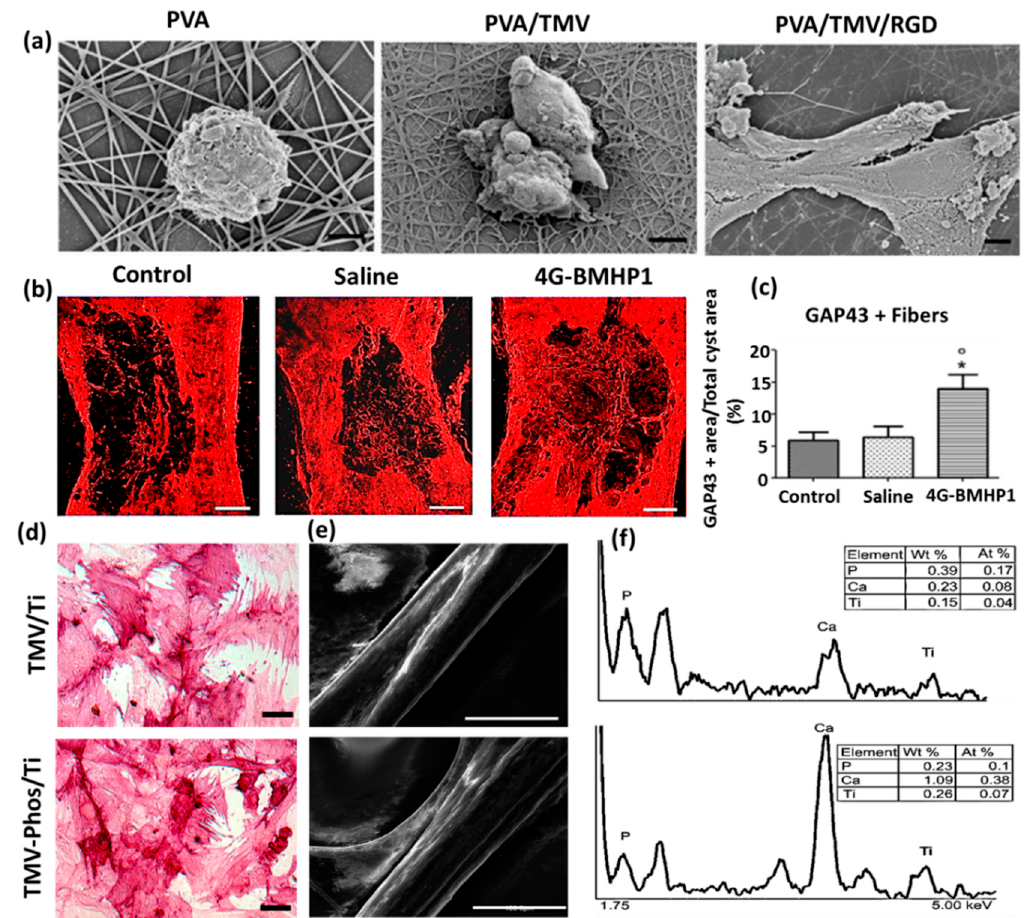
Figure 3. ( a ) Field emission scanning electron micrographs of Baby Hamster Kidney cells after 1